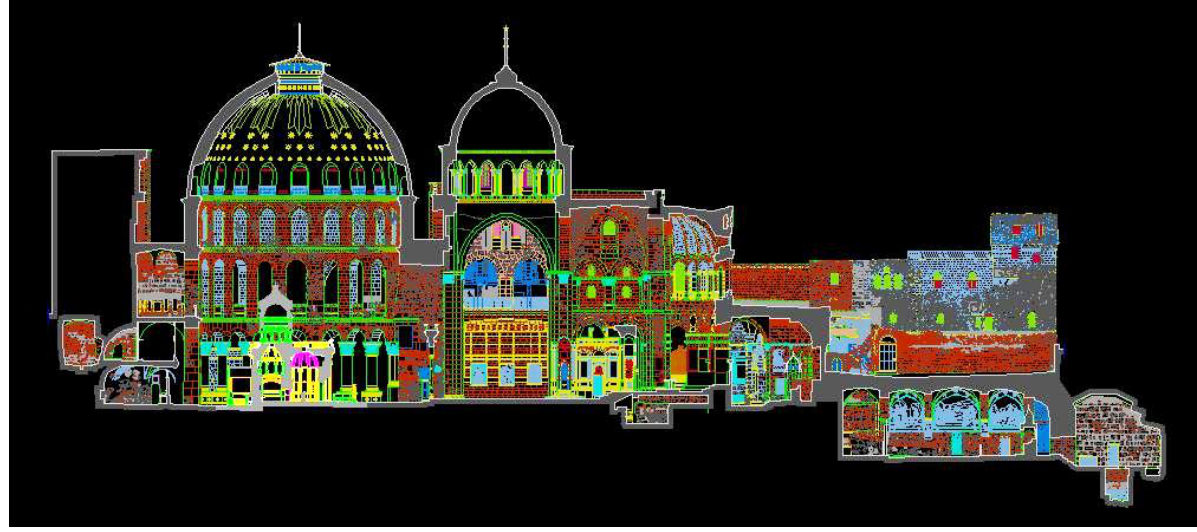
Figure 3: Sample of the geometric documentation